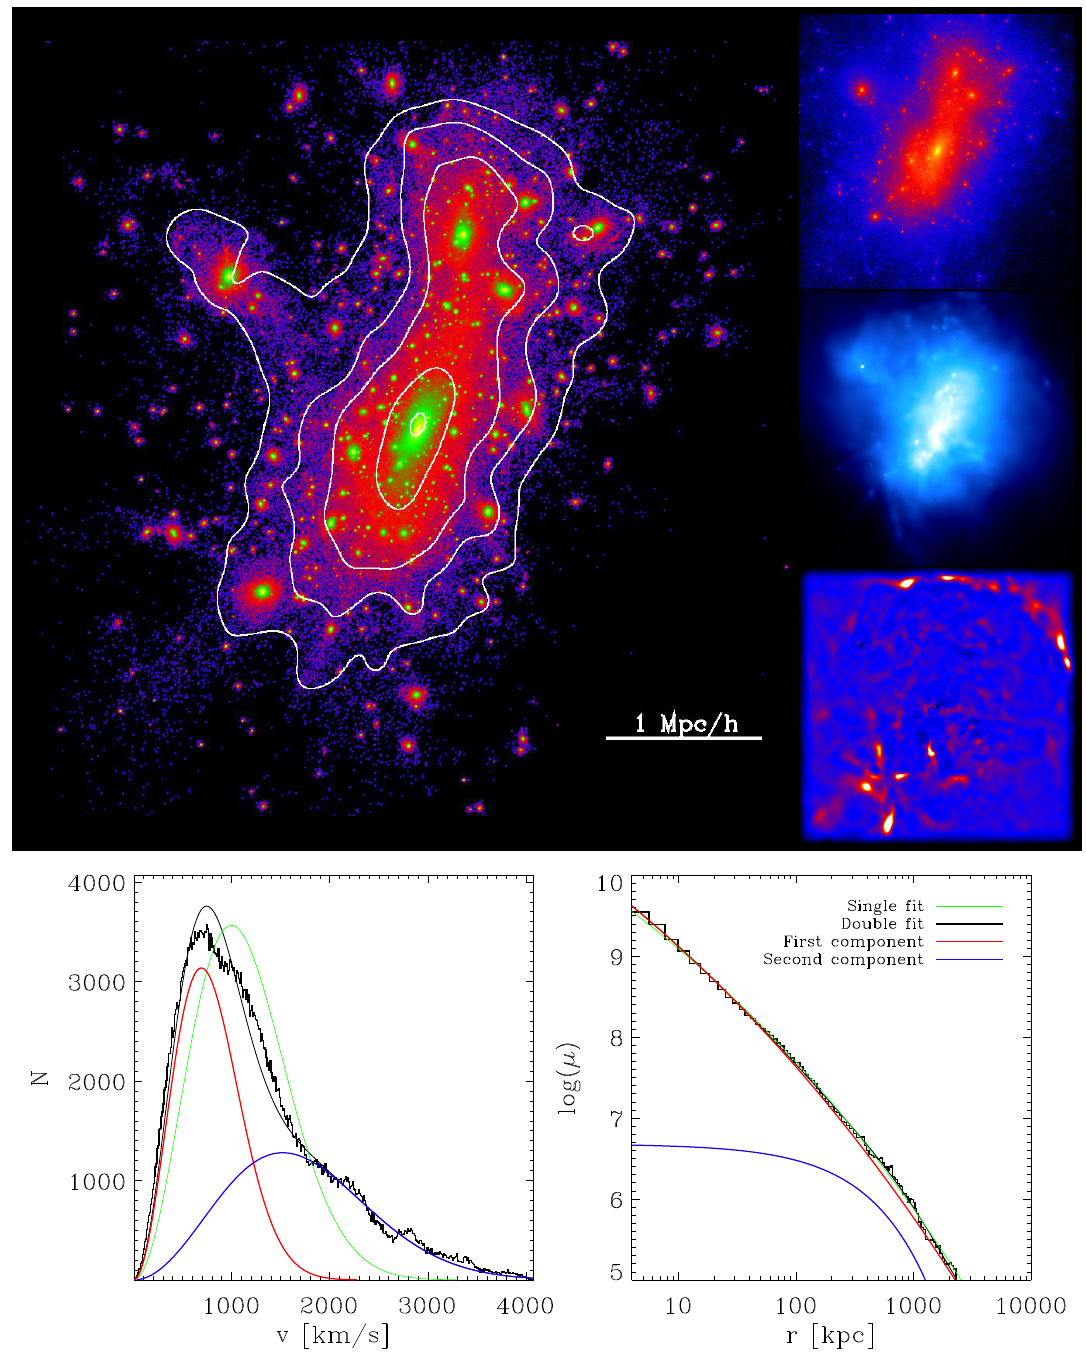
Figure 1. Example of a galaxy cluster where the velocity distribution is best described by a double Maxwellian fit, while the radial surface density profile can be well described by a single Sérsic profile (class d/s). Upper left panel : Stellar particle density map of the cluster, with the densest areas in yellow/green and the least dense areas in blue/black. White contours mark the iso-brightness lines of the DSC with the galaxies subtracted. Upper right panels, from top to bottom: Total matter density map; X-ray surface brightness map; unsharp-masked image of the pressure map to visualize shock fronts, as indicated by the large, arc-like feature in the upper right corner. Lower left panel: Velocity histogram for the stellar particles within the cluster, excluding those from substructures. (Continued in Figure